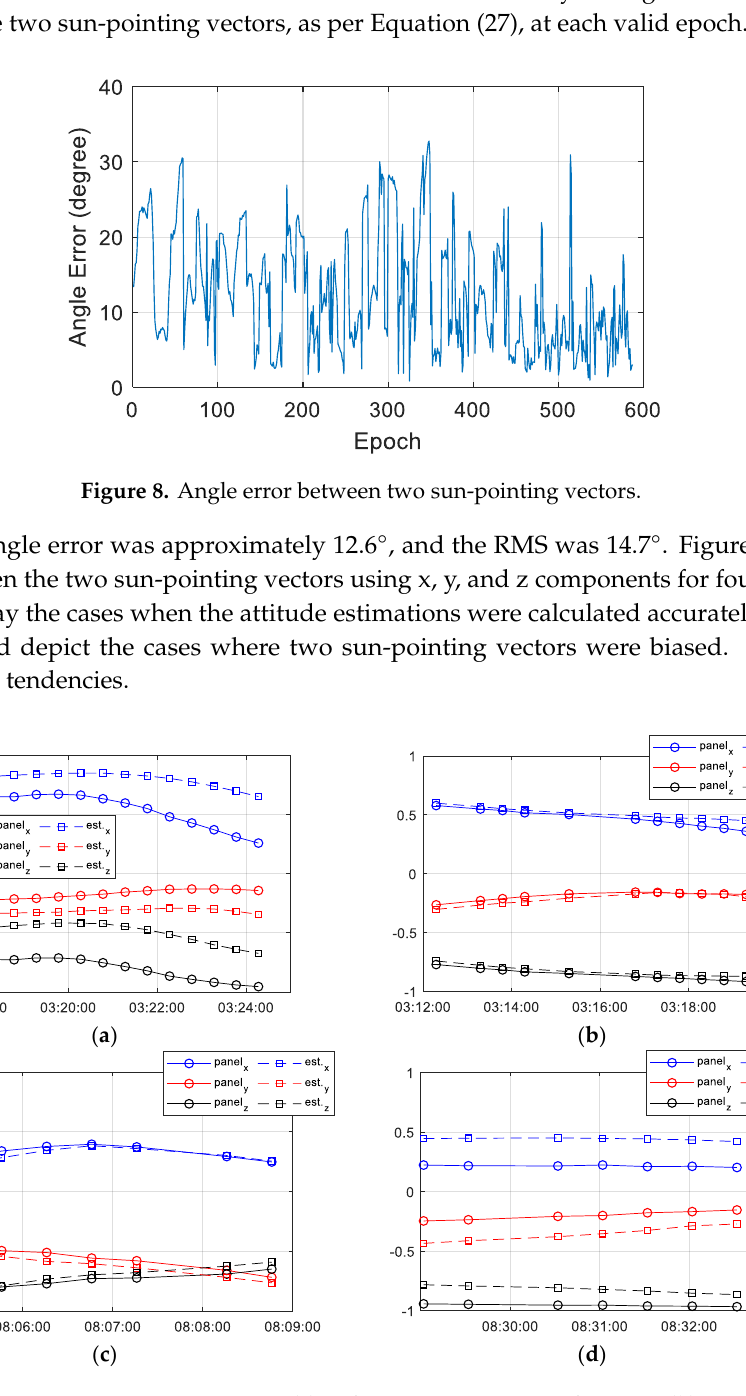
Figure 9. Sun-pointing vector comparison: ( a ) 29th contact on Dec. 11, 2018; ( b ) 161st contact on Dec. 27, 2018; ( c ) 518th contact on Feb. 17, 2019; and ( d ) 657th contact on Mar. 10, 2019.